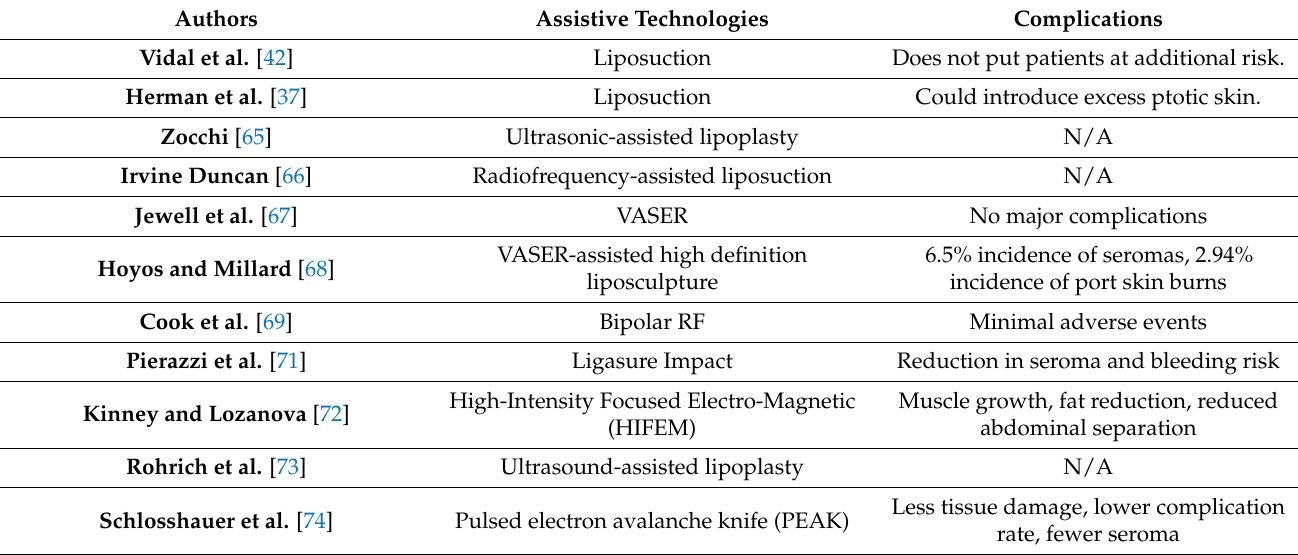
Table 3. Recent technology utilization in